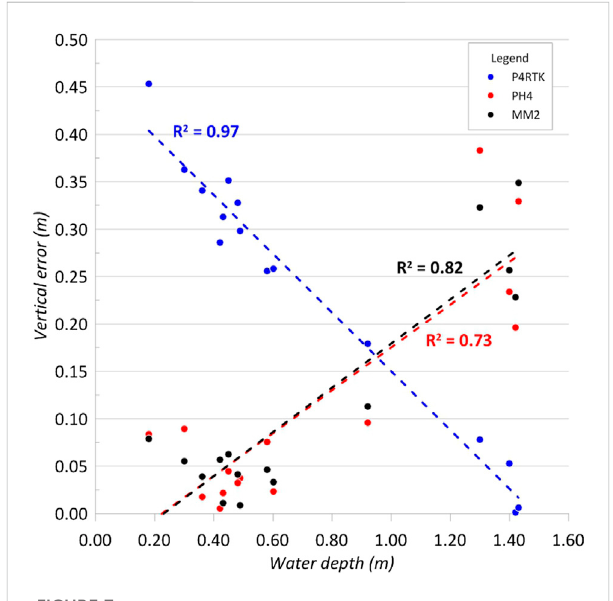
FIGURE 7 Relation between the vertical errors computed from UAS-based approaches at each target and relative water